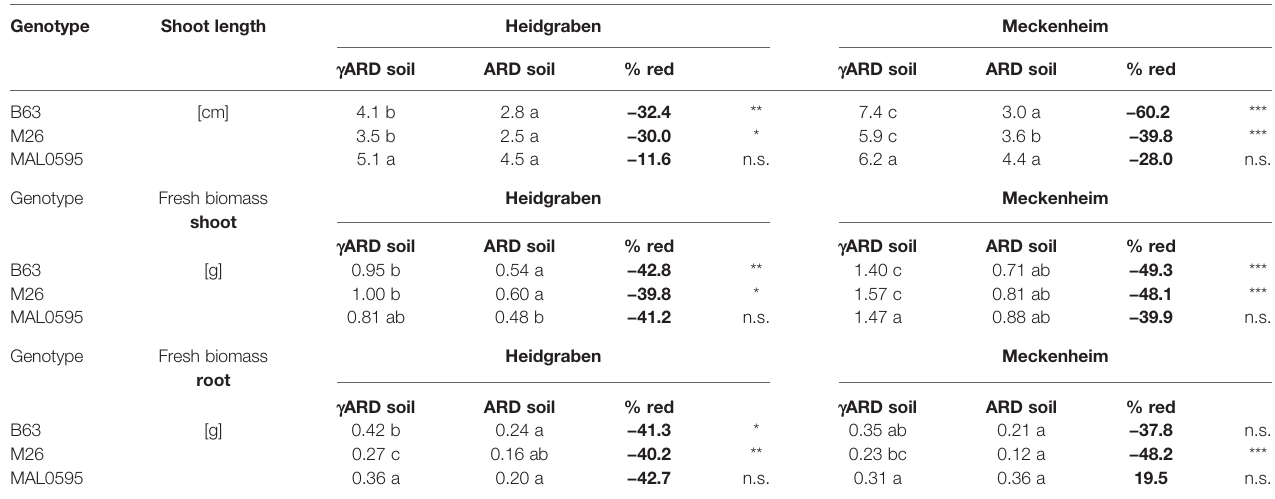
TABLE 2 | Shoot length and fresh mass of shoot and root of M26, B63, and MAL0595 4 weeks after transplanting to g ARD soil and ARD soil from Heidgraben and Meckenheim.